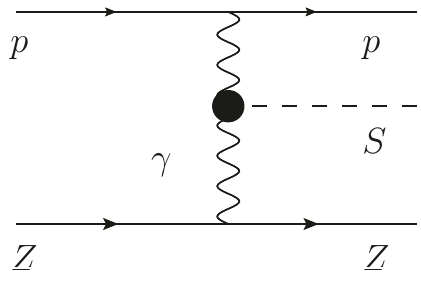
Figure 20 . A diagram of the production of a scalar in photon